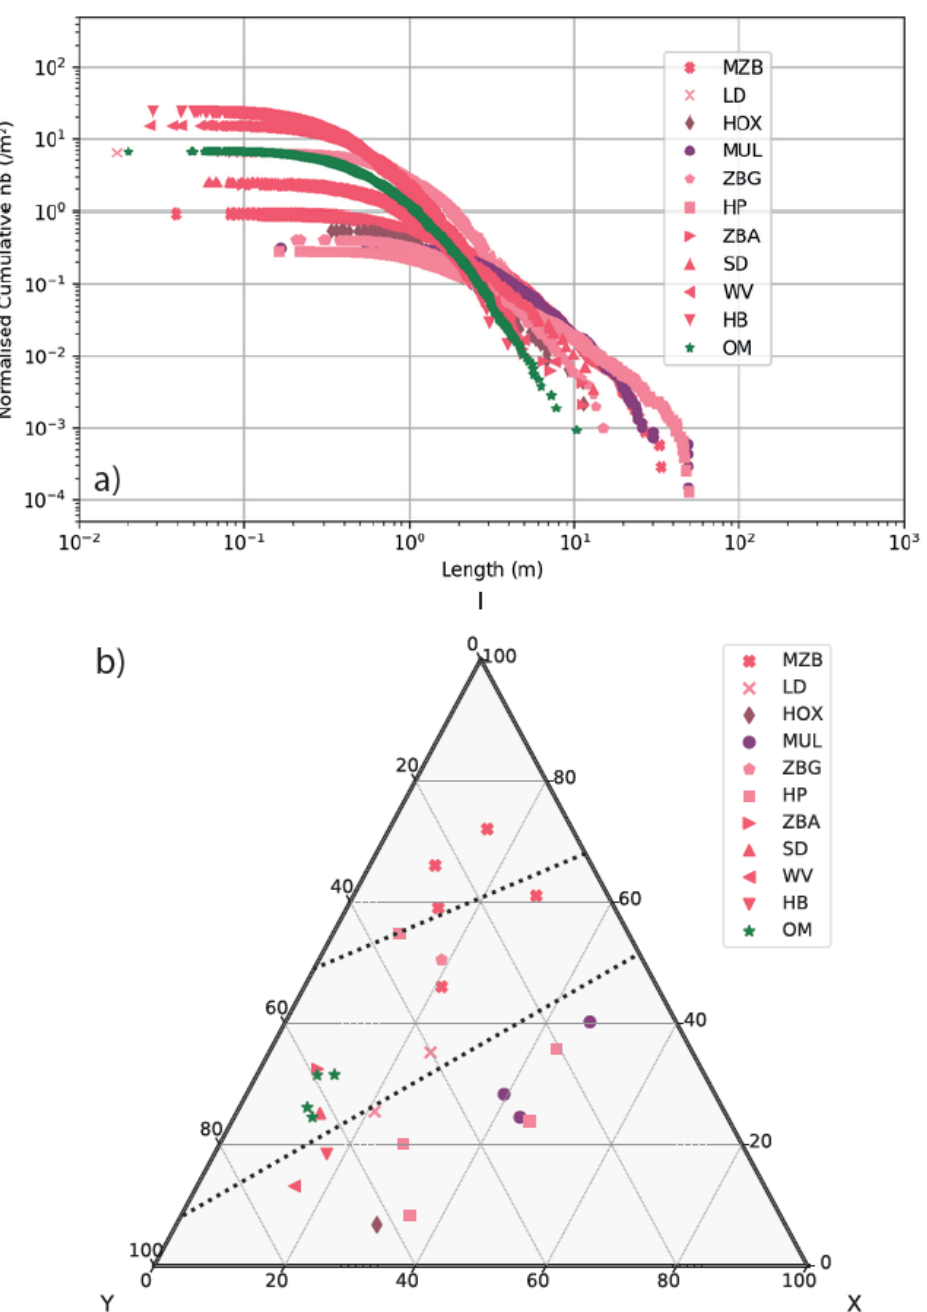
Figure 5. Fracture network features from 2D profiles and maps: ( a ) Cumulative distribution of fracture lengths from GIS analysis, ( b ) Connectivity ternary diagram. The applied colour code is related to the lithology (see Figure 1). For the list of abbreviations, see Figure 4 and Table 1. Outcrops label-